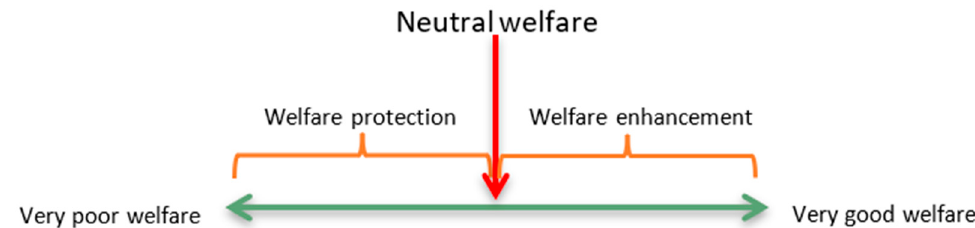
Figure 3. The animal welfare continuum and the roles of veterinarians in protecting (preventing or alleviating negative experiences) and enhancing (promoting positive experiences) on each side of neutral.